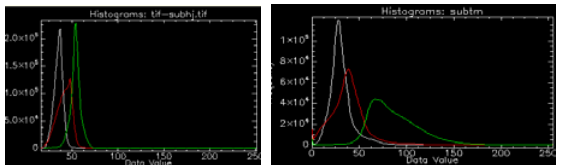
Fig.2 Histograms of 2.3.4 bands (left: from HJ image, right: from TM image)